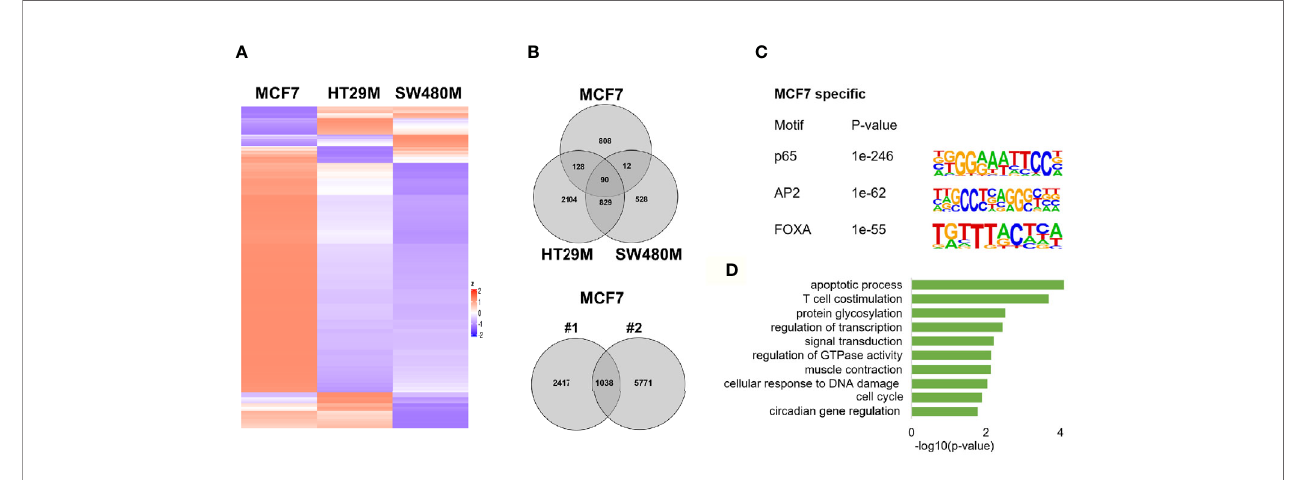
FIGURE 4 | p65 cistrome in colon vs breast. (A) Heatmap illustrating p65 binding sites in breast (MCF7) and colon cancer cell lines (HT29, SW480). (B) Venn diagram comparing the p65 binding sites in MCF7, HT29, and SW480 cells. (C) DNA motifs located in MCF7-speci fi c p65 binding sequences (D) . Pathways enriched among the gene ontology functions assigned to genes located nearest to MCF7-speci fi c p65 binding